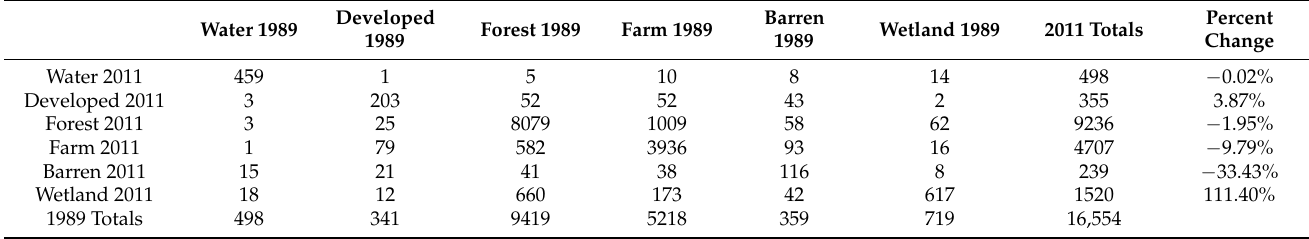
Table 4. All transitions in km 2 between land cover classes and the total percent change of each class. Rows add up to the total amount of each class in 2011 and columns show how that class was classified in 1989.